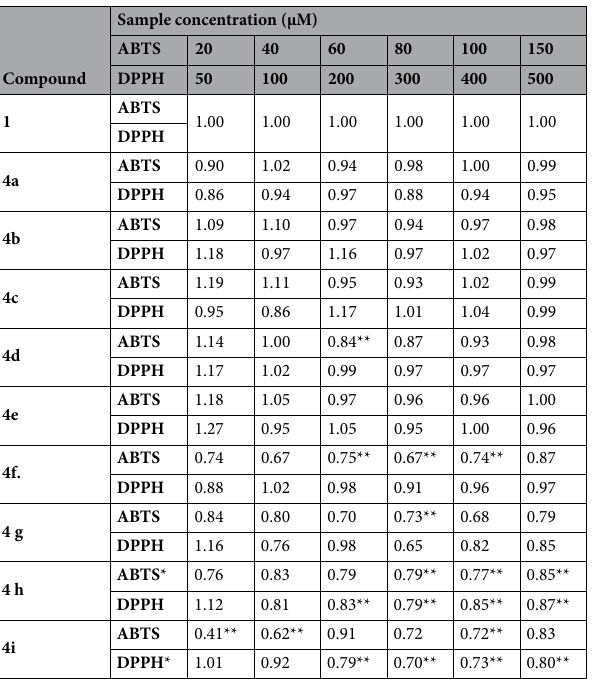
Table 2. Luteolin’s equivalence radical scavenging activity of the 5- O -acyl luteolin derivatives against ABTS radical cation and DPPH radical at various concentrations; *results obtained from in duplicate assessments instead of triplicate; ** significantly different ( p <